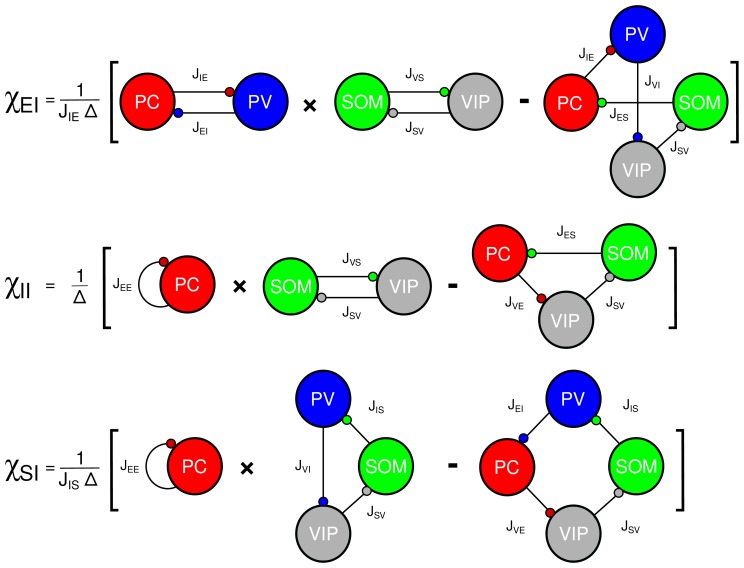
Graphical representation of the population susceptibilities upon stimulation of PV in Model 1 (large N, E limit).The prefactor in front of each diagram accounts for the fact that additional terms are needed to complete the loops. Note: χVI=JSEJSVχEI.